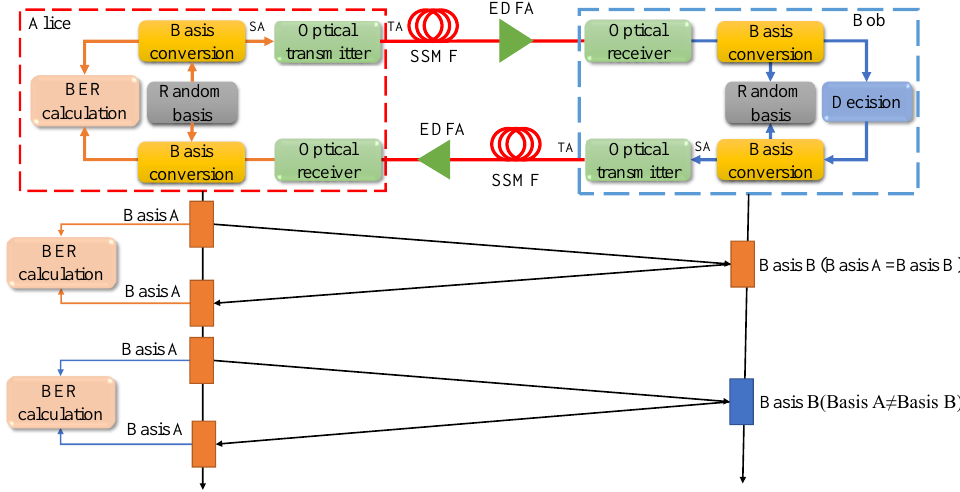
Figure 2. Key distribution scheme based on the masking effect of fiber channel noise.